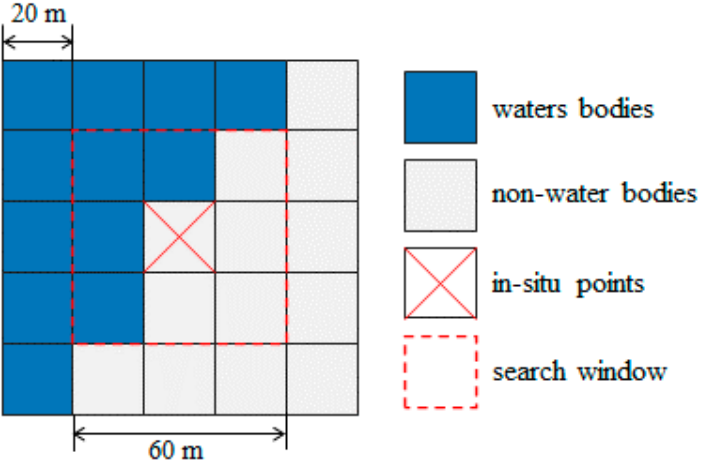
Figure 3. Illustration of the 3 × 3 window selection method used to identify and characterize water pixel points.